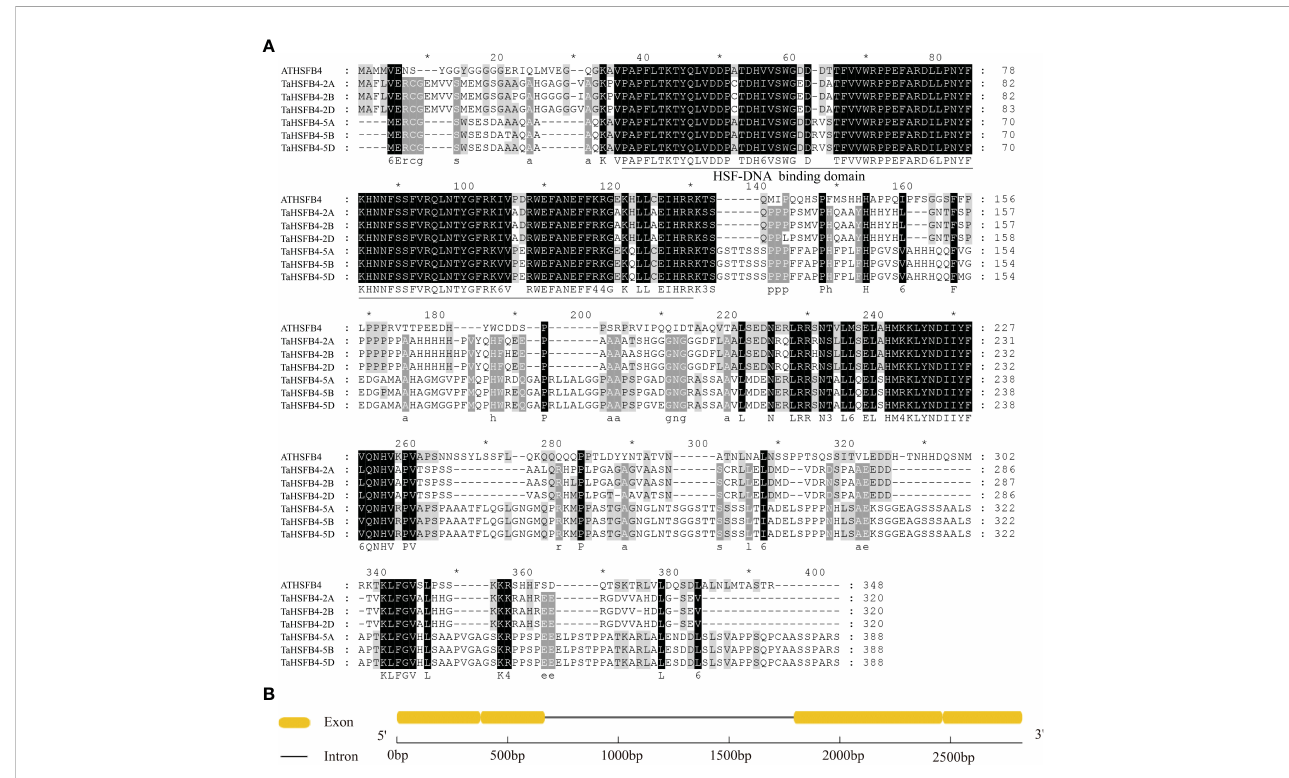
FIGURE 4 Amino acid sequence alignment of HSFB4s subfamily members. (A) Multiple sequence alignment of predicted amino acid sequence of TaHSFBs and AtHSFB4. Grey represents different degrees of conservation among sequences, black indicates identical residues, white indicates conservative changes. The conserved HSF-DNA binding domain was underlined. (B) TaHSFB4-2B gene sequence